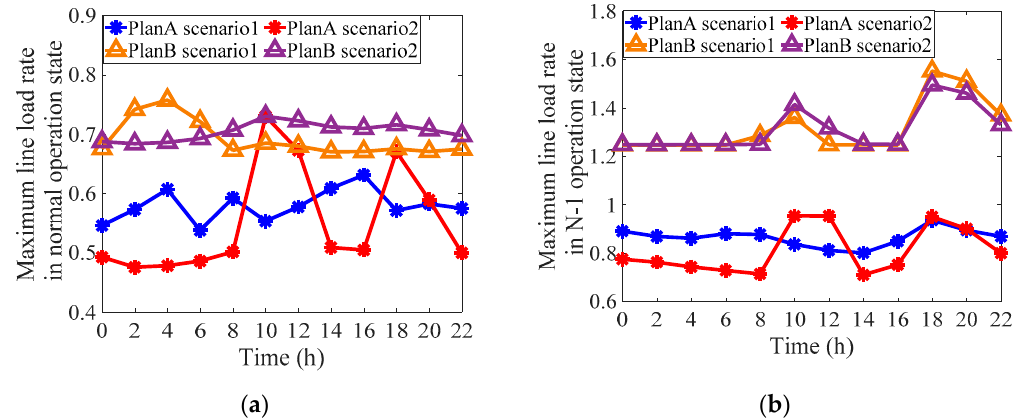
Figure 8. The changing of the highest line load rate. ( a ) Normal load rate; ( b ) N-1 load rate.